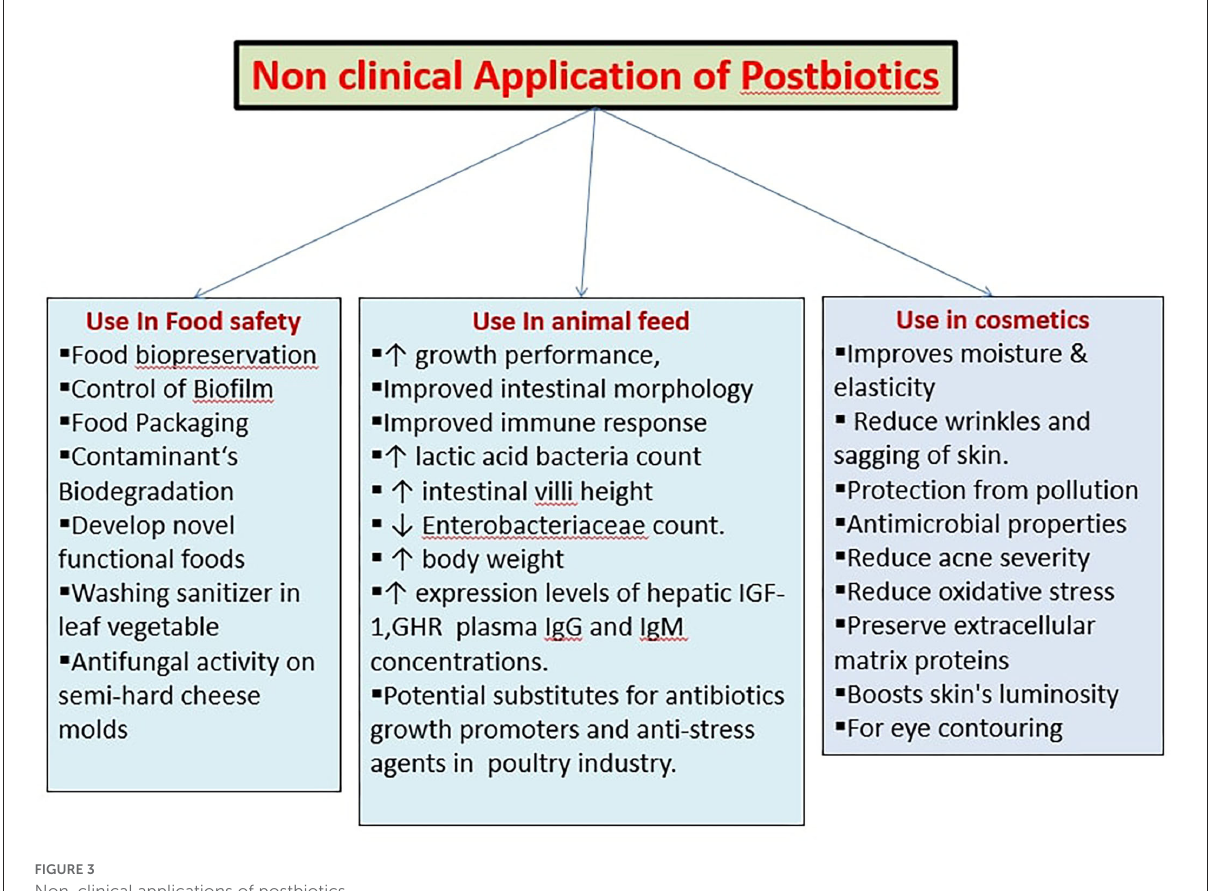
FIGURE3 Non-clinical applications of